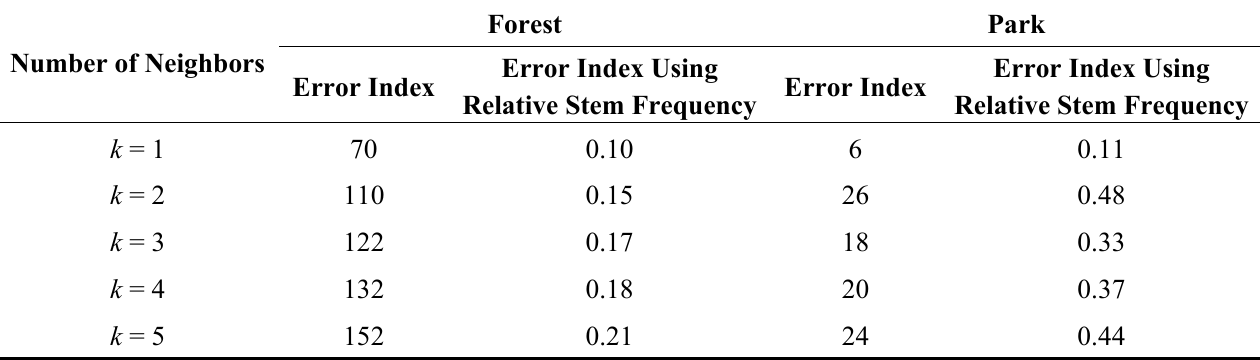
Table 6. Reynolds’ error indices for the predicted stem-diameter distributions using a bin size of 2 cm.